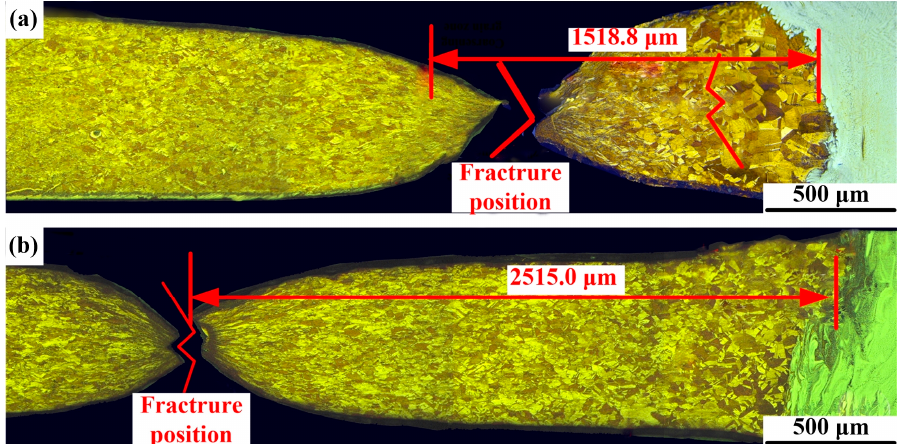
Figure 15. Fracture position of joints: ( a ) joint 1 and ( b ) joint 2.